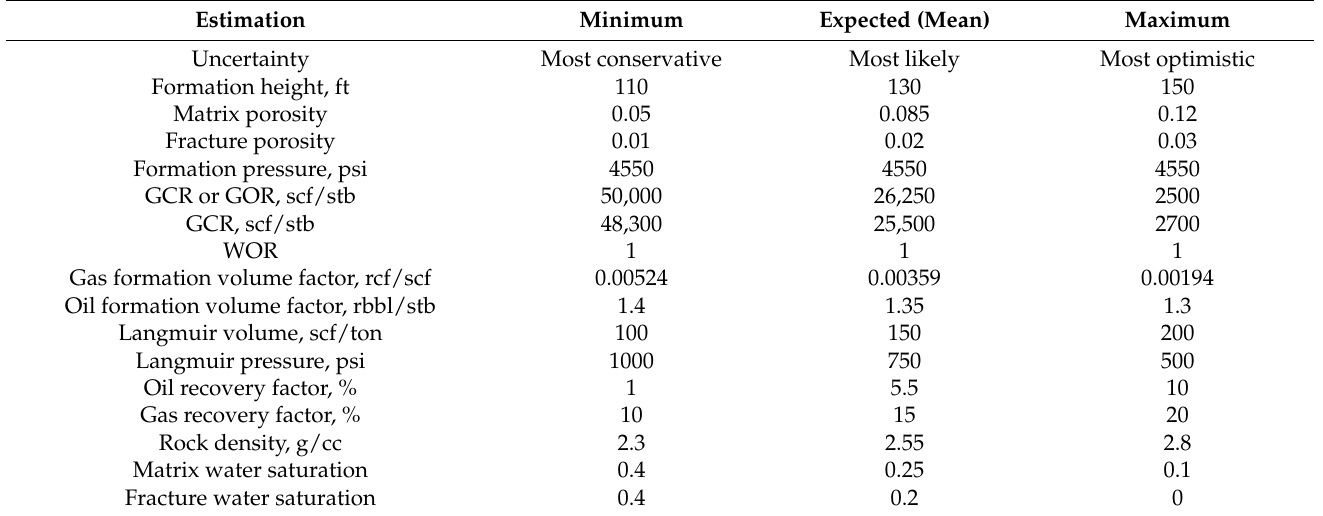
Table 5. Input parameters for three cases.